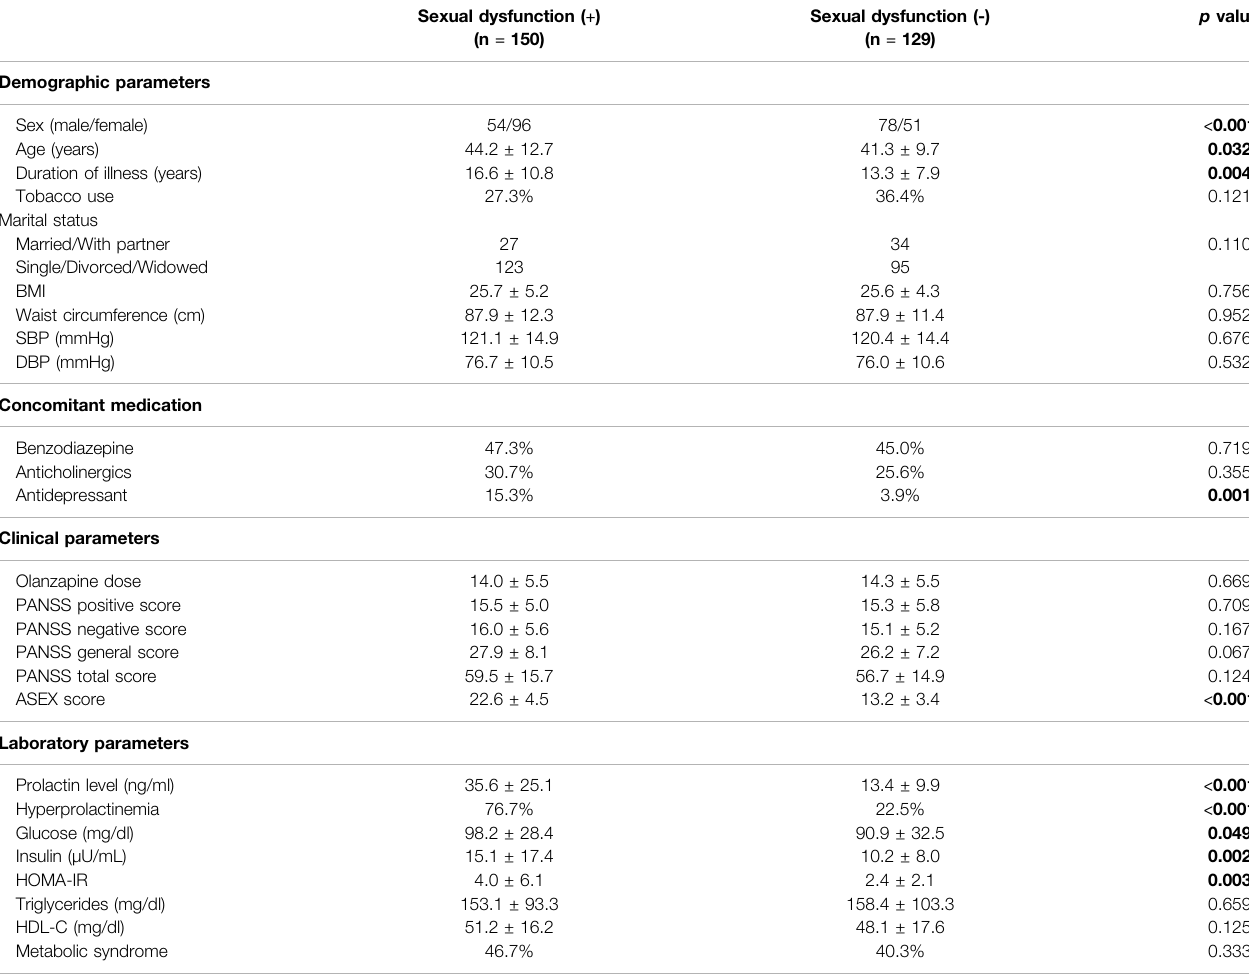
TABLE 3 | Demographic, clinical and laboratory characteristics of study subjects by sexual dysfunction.